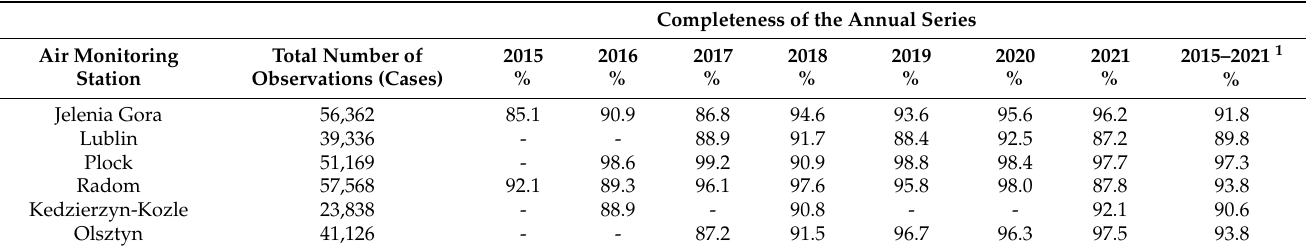
Table 2. Completeness of the time series after removing cases with missing data, 2015–2021.